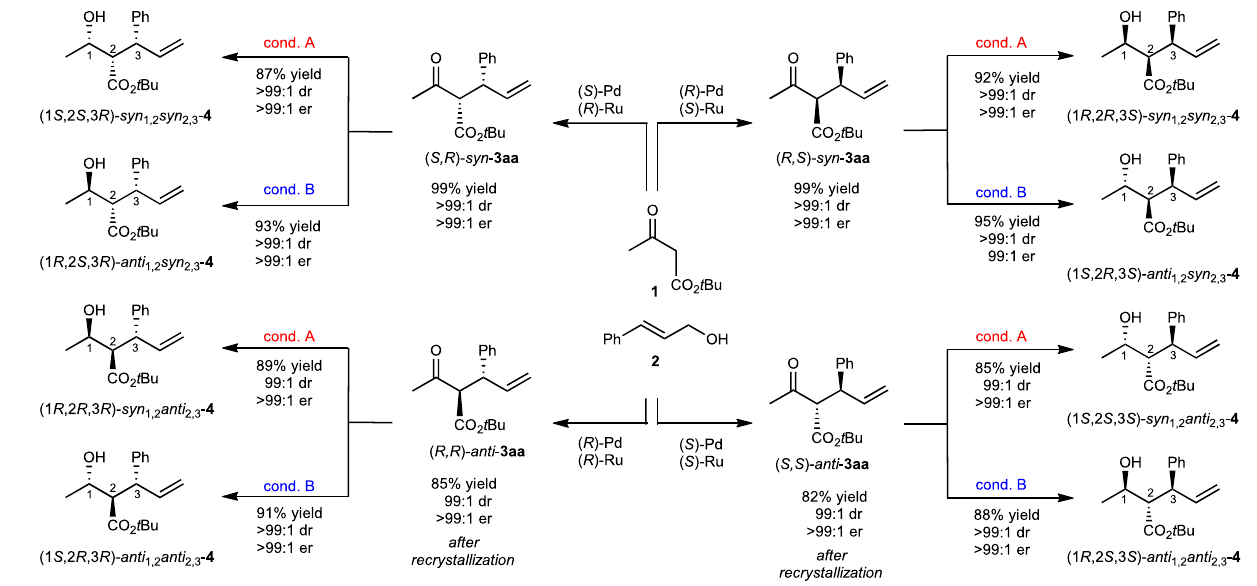
Fig. 4 | Acyclic stereocontrolled synthesis of eight possible isomers with three adjacent stereogenic centers. Condition A: [ 3aa ]=0.1M, K-selectride 0.35M, THF, − 78°C, 12h; Condition B: [ 3aa ]=0.1M, Zn(BH 4 ) 2 0.1M, CH 2 Cl 2 -Et 2 O, 0°C, 6h. THF: